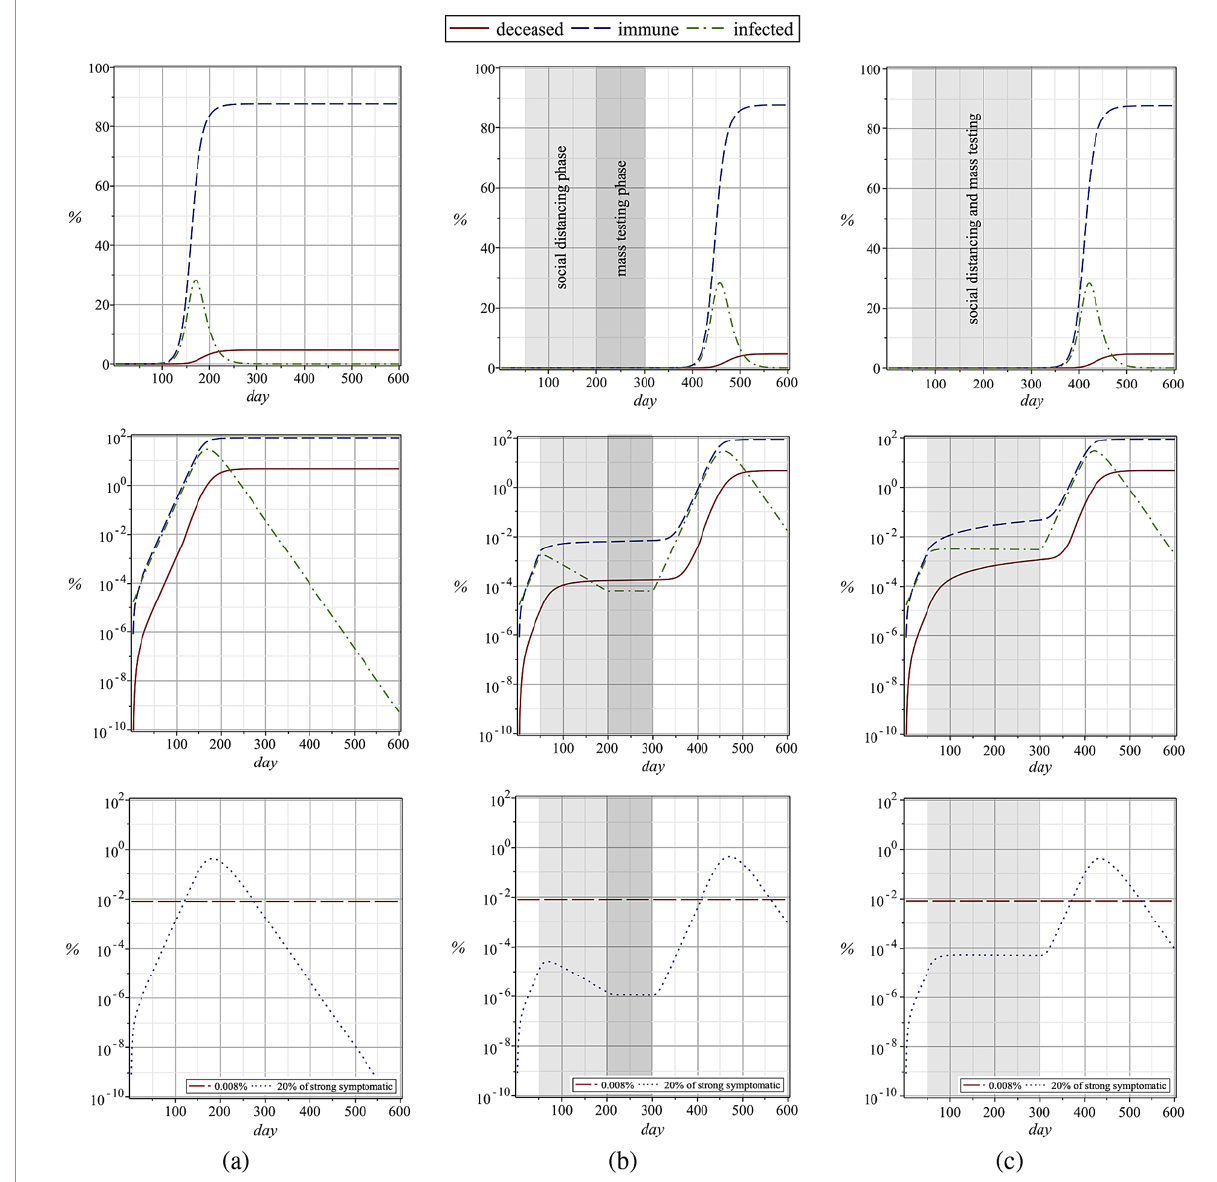
Figure 8: Mass testing combined with social distancing. (a) base case; (b) social distancing phase from day 50 to day 200 with 71% lower infection rate followed by mass-testing period of 100 days with a testing interval of 7.92 days and one day processing time; (c) social distancing and mass testing at the same time from day 50 till day 300 with a 33% lower infection rate and a test- ing interval of 22.46 days and one day processing